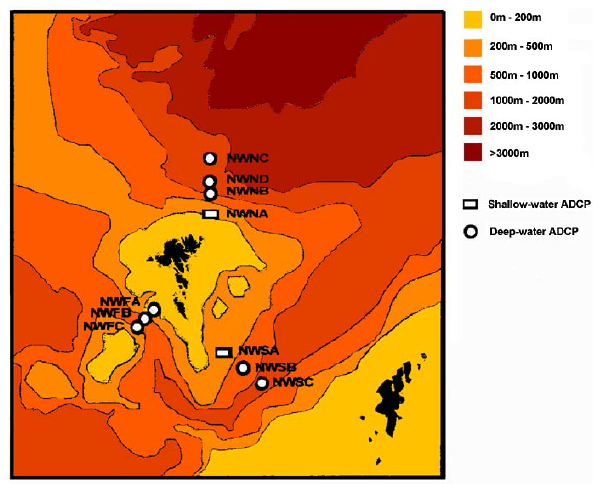
Fig. 1. VEINS deployments in sections N (north of the Faroes), F (Faroe-Bank Channel), and S (Faroe-Shetland Channel) (modified from Hansen et al. (1999a)).